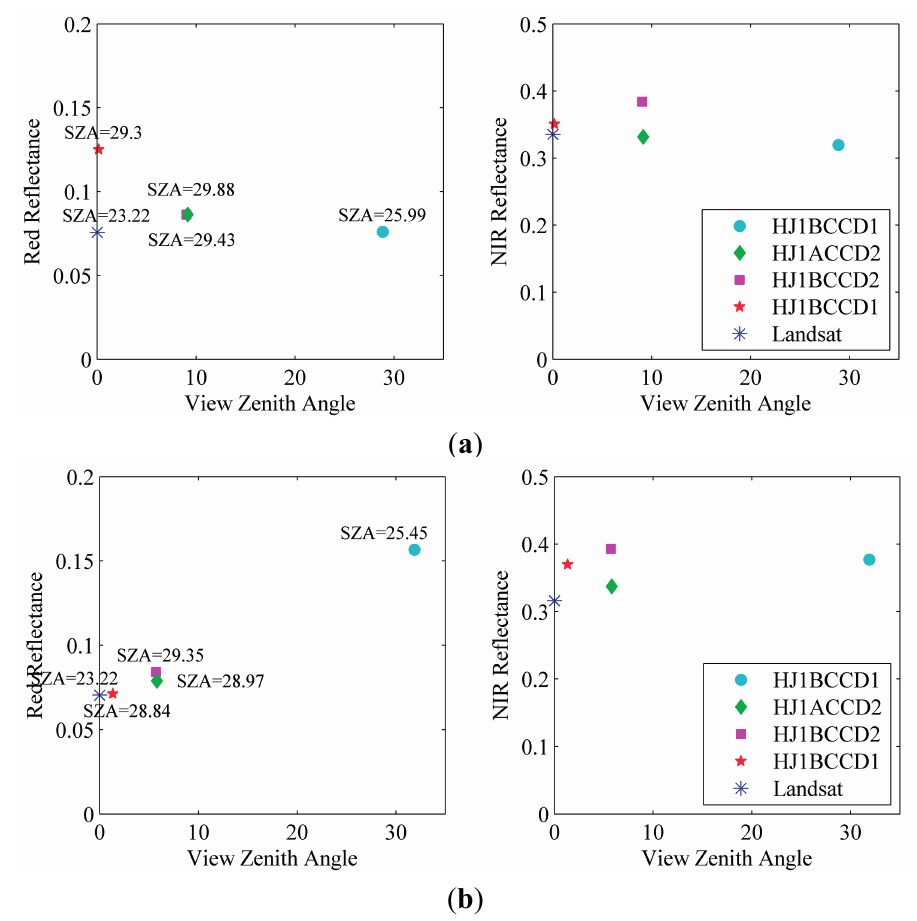
Figure 9. Variation between different sensor observations for crops ( a ) and forests ( b ) from 21 to 30 June